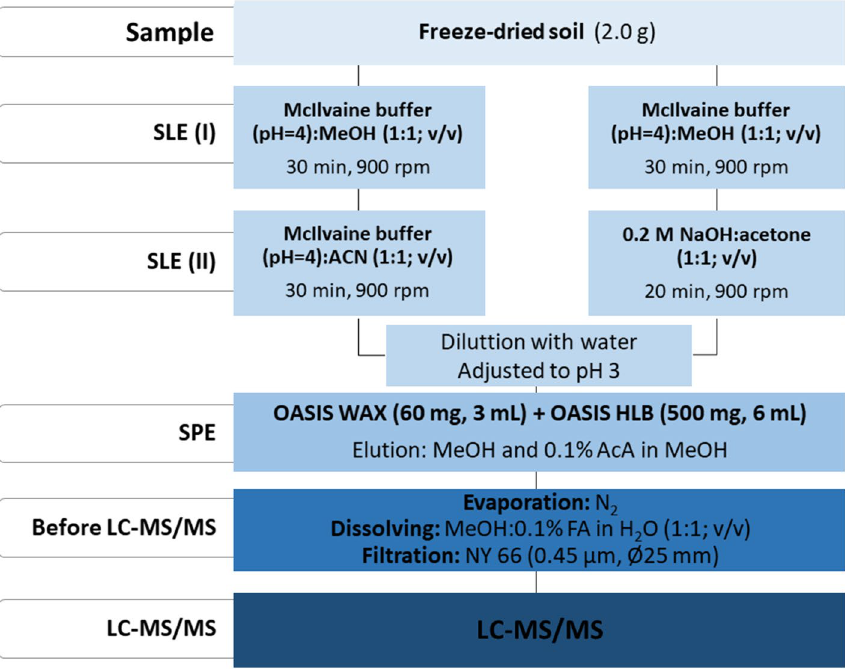
Figure 1. Schemat of the developed extraction